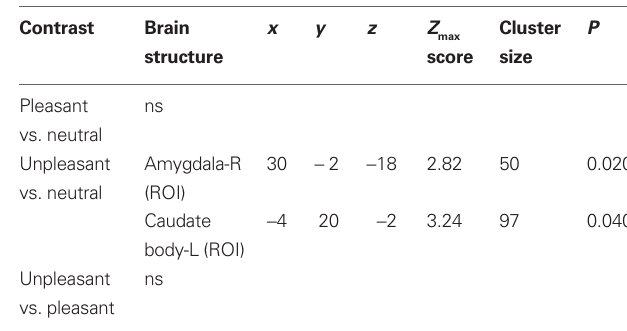
Table 3 | Significant correlations with arousal ratings revealed by whole brain (WB) and regions of interest (rOi)